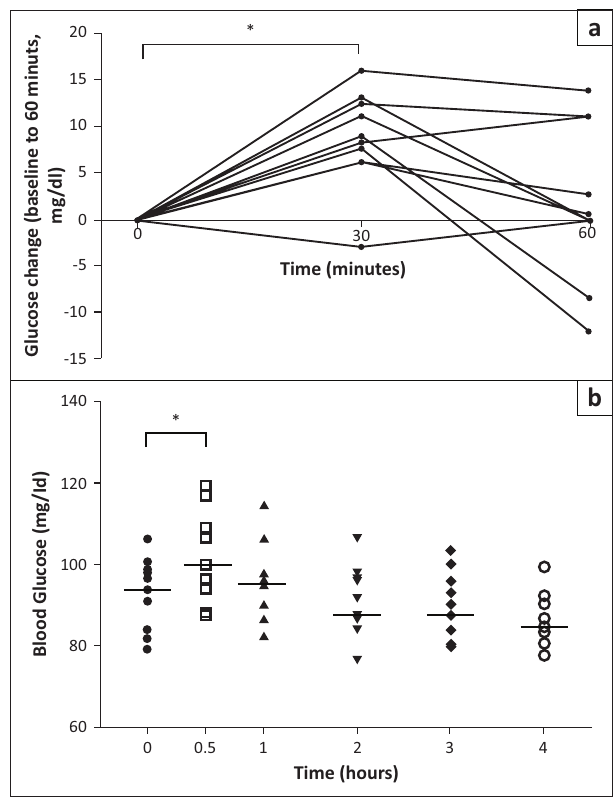
FIGURE 4: Blood glucose responses to PF. (a) Adjusted individual blood glucose changes (from baseline) at 30 min and 60 min. The magnitude of blood glucose change at 30 min ranged from -2.8 mg/dl to +16.0 mg/dl. In 70 % of participants, glucose had returned to baseline by 60 min. (b) Scatter plot (line at median) of blood glucose at baseline (fasting) and across the 4-h study period. Median (95 % CI) blood glucose after 30 min had increased from 94 mg/dl (79 mg/dl–101 mg/dl) to 100 mg/dl (87 mg/dl–116 mg/dl), which was statistically significant ( p = 0.002). Blood glucose returned to baseline by 1 h and remained similar to baseline for the remainder of the experimental period.